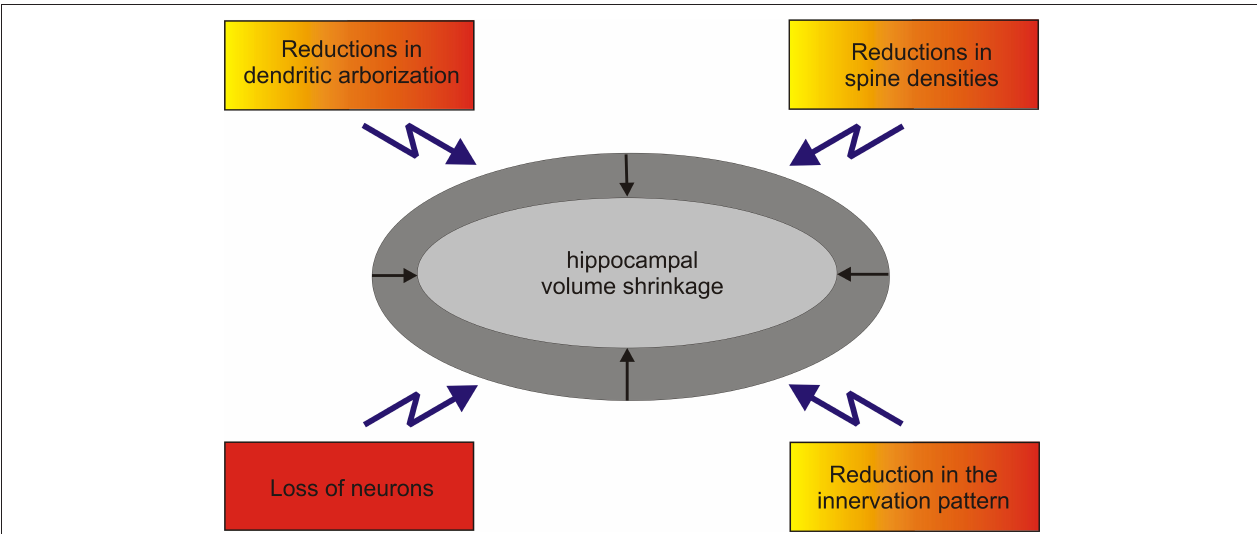
Figure 1 | Hippocampal volume reduction is the sum of different morphological changes. Volume shrinkage seen during normal aging (yellow) or in major depression (orange) is not due to a severe loss of hippocampal neurons. Hippocampal volume reduction together with severe losses of hippocampal neurons could e.g. bee seen in Alzheimer’s disease